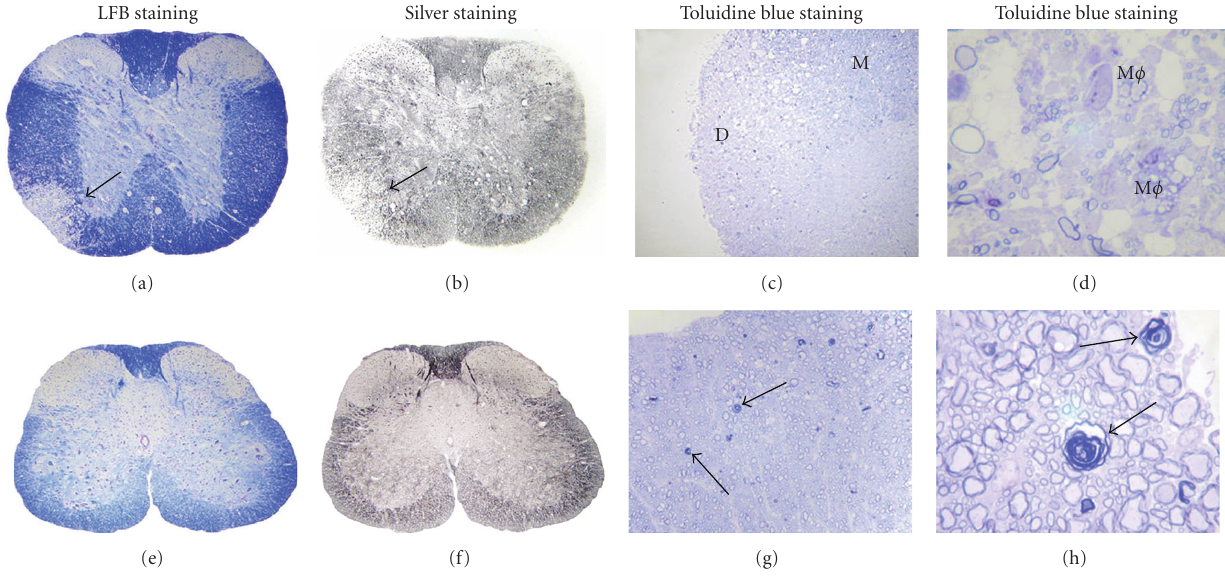
Figure 13: Demyelination and axonal loss in DM- and NDM-infected mouse spinal cord. Serial cross-sections (5 μ m thick) from DM- and NDM-infected mouse spinal cord at day 7 p.i. were stained for myelin with LFB (a, e) or by Bielchowsky silver impregnation (b, f) or toluidine blue to delineate preservation of myelin, axons, and axon-myelin coherence following DM and NDM infection. (a) A large demyelinating plaque observed in DM-infected mouse spinal cord is shown (arrow indicates demyelinated area). (b) In an adjacent section, the same demyelinating plaque of DM-infected spinal cord showed loss of axons (arrow indicates area of axonal loss). (e) Normal myelin was observed in NDM-infected mouse spinal cord. (f) No axonal loss was observed in the NDM-infected mouse spinal cord. Spinal cord sections (1 μ m thick) of mice sacrificed 30 days p.i. with DM and NDM were stained with toluidine blue (c, d, g, and h). Large demyelinated plaques were observed in DM-infected mouse spinal cord (C.D) . Myelinated spinal cord white matter region is marked (M), demyelinated region of spinal cord white matter (d), gray matter (g), macrophages (M φ ). In NDM-infected mouse spinal cord, myelin remains relatively preserved with rare examples of early axonal degeneration characterized by loss of the central axon and collapse of the myelin sheath (arrows) (g, h). Original magnification for (a, b, e, and f) is 40x. Original magnification for (c, g) is 100x and fot (d, h) is 1000x. (adapted from the work of [73])